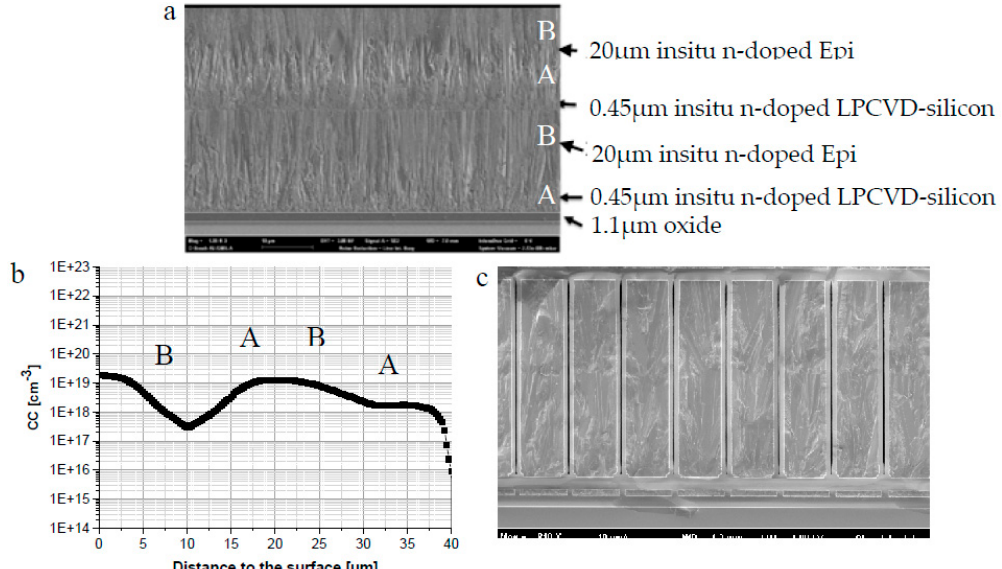
Figure 2. ( a ) SEM image of the 2 × 20 μ m Epi with 450 nm n-doped LPCVD-silicon; ( b ) Spreading Resistance Profiling for the silicon-stack. ( c ) SEM picture of 40 μ m refill trenches with 2.5 μ m LPCVD TEOS (1 μ m sidewall passivation).